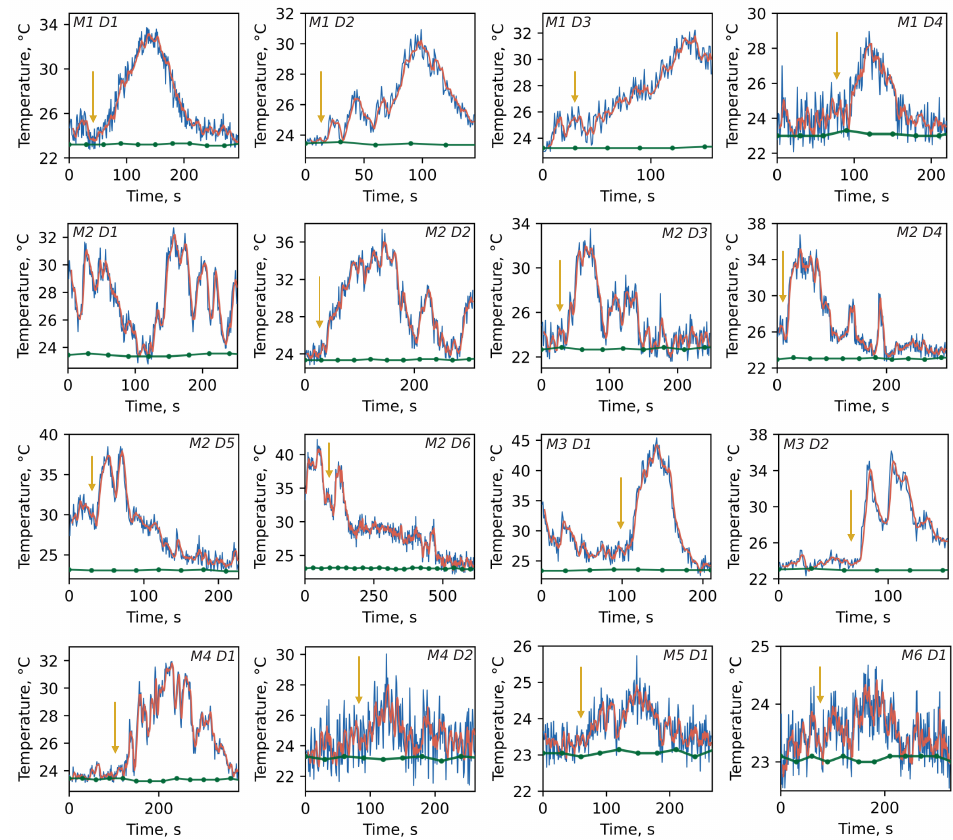
Figure 3. Time tracks of the temperature recorded when DT was in close proximity to individual mitochondria aggregates. The primary data directly measured by DT are indicated in blue and smoothed data are given in red for visual purposes. The green curves are thermocouple temperature readings of the whole solution. The yellow arrows specify the moment of CCCP injection (2.5 µ L). The text at the right or left-top corners specifies the mice (M) and dish (D) number for which the temperature was measured. Note that the dish numbers are shown in chronological sequence with an average time between each one being approximately 20 min. The difference in the noise level is related to different thickness of the suspension layer and, therefore, dissimilar turbidity of the